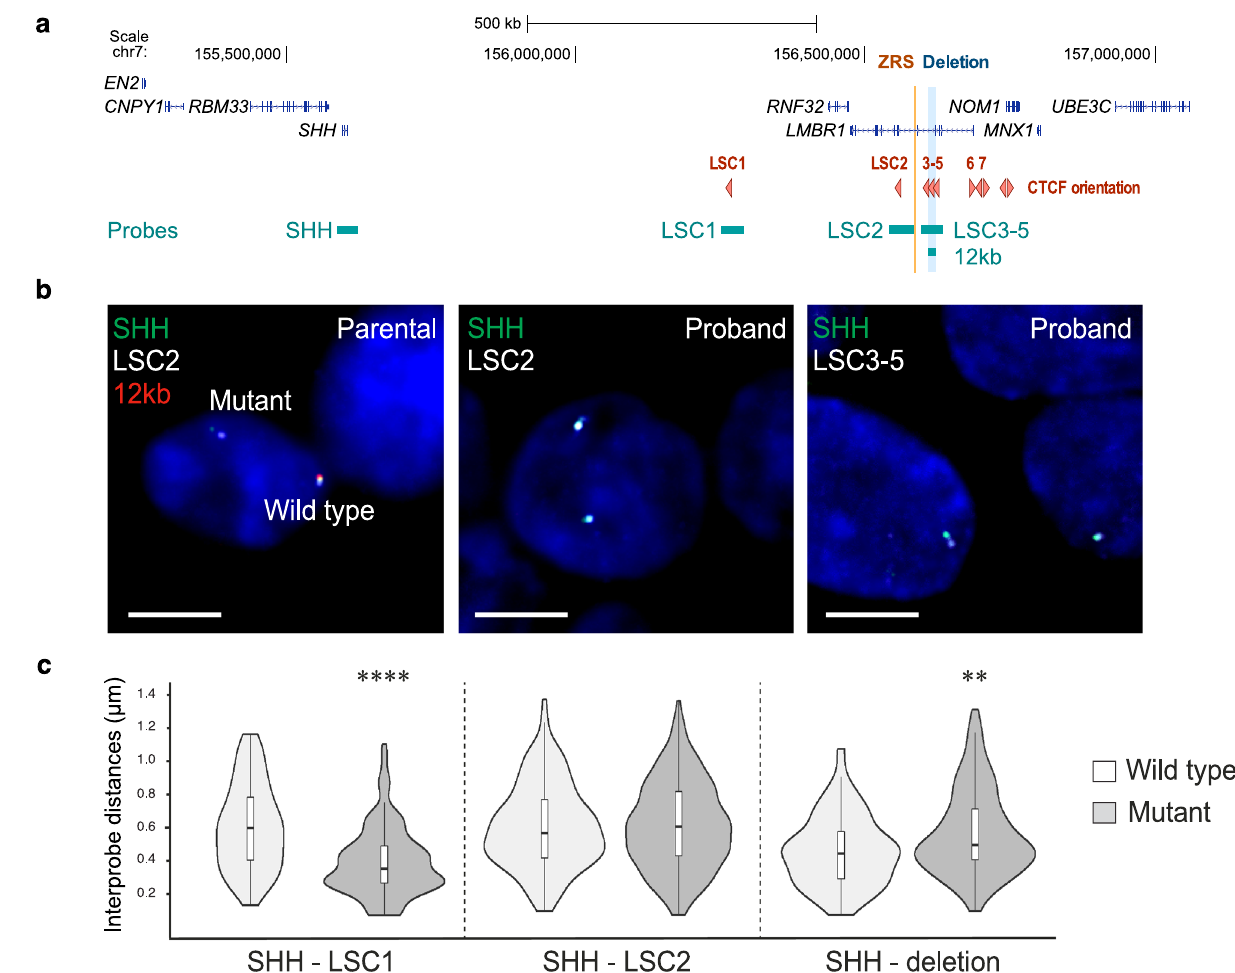
Fig. 5 DNA FISH showing the SHH promoter interaction with the acheiropodia-associated region. a Schematic of the LMBR1-SHH locus showing the ZRS and the acheiropodia-associated deleted region via orange and blue vertical lines respectively. CTCF orientations are shown as red triangles and the locations to which the DNA FISH probes hybridize to are depicted by light blue bars. b Images of representative nuclei from DNA FISH analysis of parental and proband lymphoblastoid cells showing FISH signals for SHH, LSC2, LSC3-5, and 12 kb probes. Scale bars: 5 µ m. c Violin plots showing the distribution of interprobe distances ( µ m) between SHH – LSC1, SHH – LSC2, and SHH – Deletion. The wild-type allele was distinguished from the mutant allele in the parental cell line using the 12 kb probe. SHH – deletion is measured from SHH to 12 kb probe on the wild-type allele and from SHH to LSC3-5 probe on the mutant allele. The statistical signi fi cance between datasets was examined by a two-sided Mann – Whitney U-test, ** = 0.004537 and **** = 2.083×10 − 11 ( n = 75 – 150